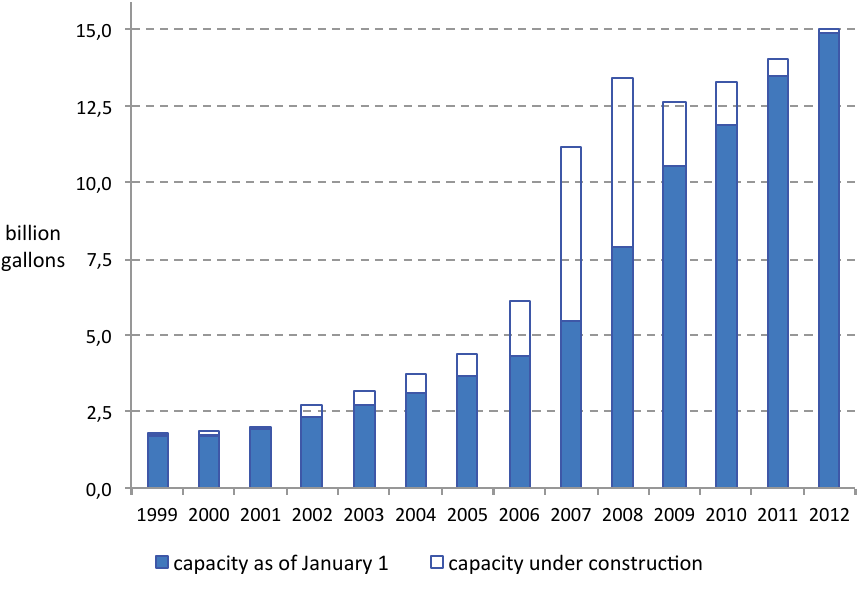
Figure 3. Growth of the US Ethanol Industry: capacity